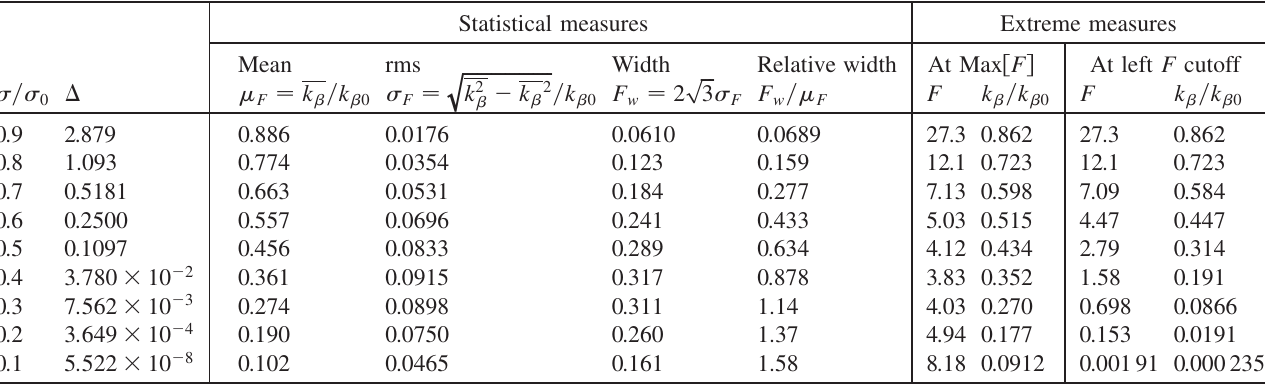
TABLE IV. Statistical and extreme values of the frequency distribution F for the thermal equilibrium sheet-beam parameters plotted in Fig. 7. Values tabulated are illustrated graphically in Fig.